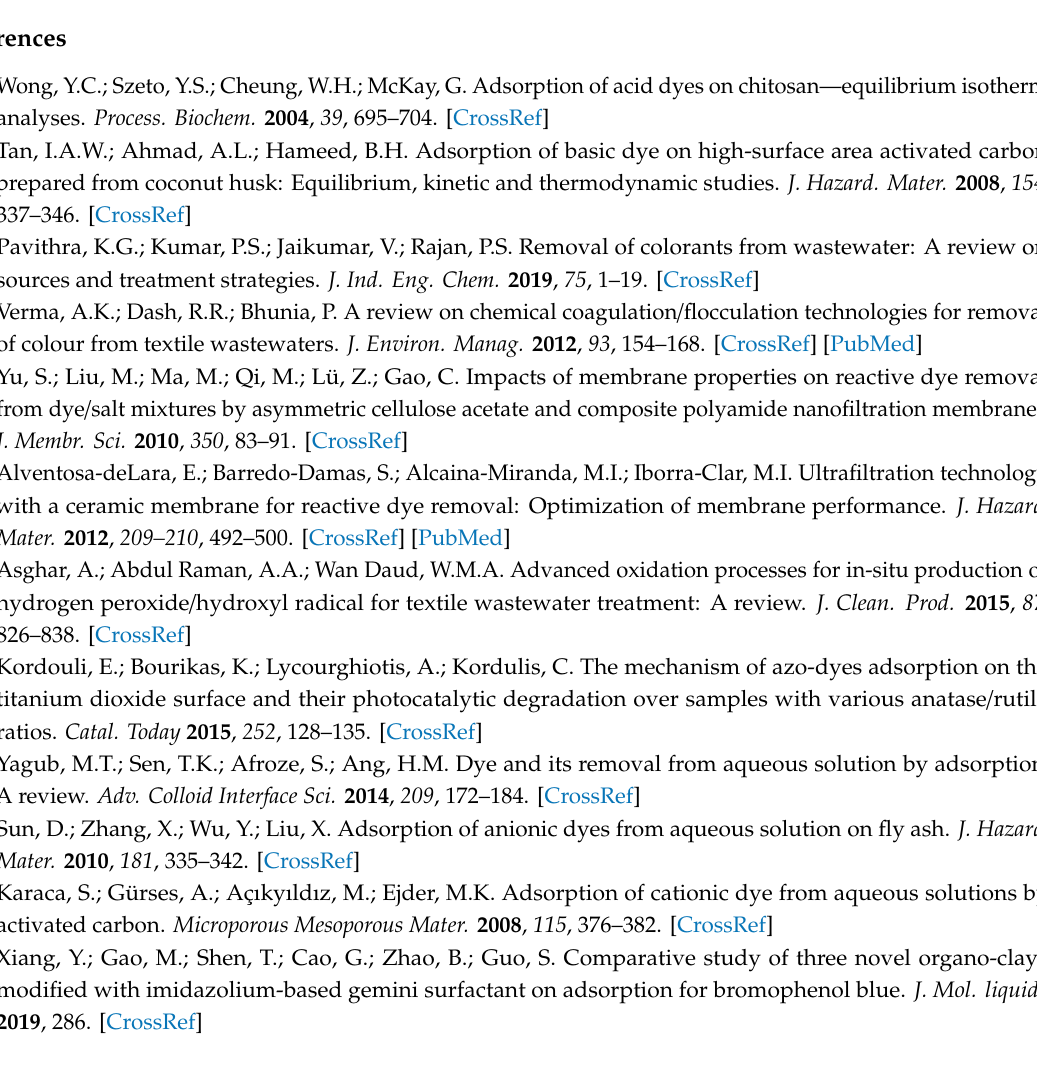
Figure S1: title, Table S1: title, Video S1: title. Figure S1: MB standard curve (at pH of 5). Figure S2: The intraparticle di ff usion model plots for the adsorption of MB on SLS-C (a) at MB concentration of 10 mg / L, and (b) at MB concentrations of 10, 30, and 50 mg / L. Table S1: The water quality parameters of di ff erent water